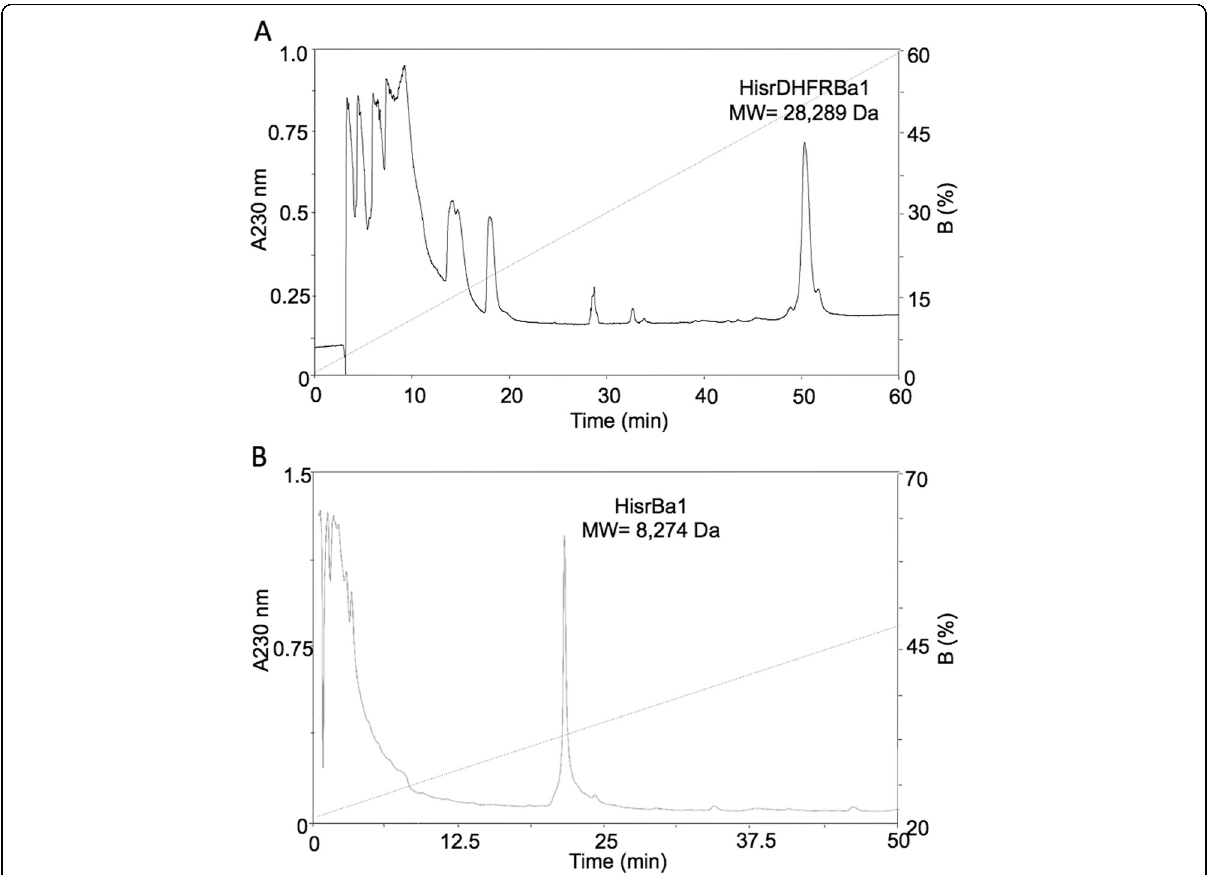
Fig. 3 rpHPLC separation of oxidized pQE40HisrDHFRBa1 or pET28HisrBa1 from affinity chromatography. a The fractions from NiNta were separated employing rpHPLC (C18 column) using a gradient from 0 to 60 % B in 60 min at 1 mL/min. b The fractions from NiNta were separated using rpHPLC (C18 column) using a gradient from 0 to 50 % B in 50 min at 1